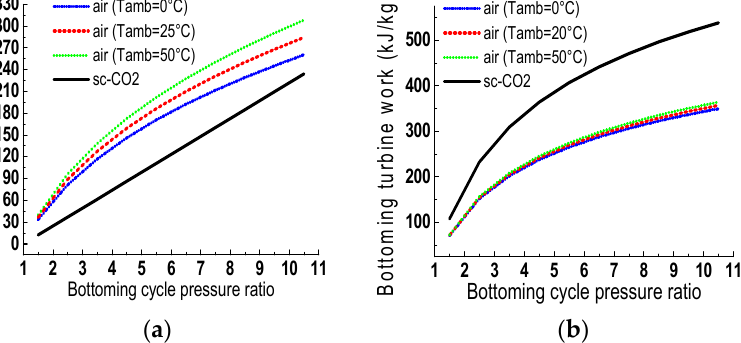
Figure 7. Recovered heat versus bottoming cycle pressure ratio with air at different ambient tem- peratures and with sc-CO 2 . B. Effect of the Ambient Temperature The gas turbines can be used under hard climatic conditions. Far from the ISO stand- ards, the ambient temperature varies considerably during the year; it can often reach over 50 °C involving an important reduction in its performance. Figure 8a–c show the sensitiv- ity degrees of GT-ABC and GT-sc-CO 2 BC net output power and energy and exergy effi- ciency gains, according to the ambient temperature which increases from 0 to 50 °C. Con- trary to the previous case where ASC performances were not sensitive to changes in the parameters set out above, when the ambient temperature varies, ASC performances are directly affected because the inlet air of both topping and bottoming compressors is at atmospheric conditions. Unlike GT-ABC, where the net output power and energy and exergy efficiency gains decrease with the increase in ambient temperature, in GT-sc- CO 2 BC, these performances increase. For an ambient temperature of 50 °C, there is a de- cline in GT-ABC output power gain (Figure 8a), resulting in a decrease in thermal and exergy efficiencies. In Figure 8a, it is noticed that for low temperatures less than 13 °C, the net output power gain difference between the two cycles is weak and their efficiencies are very close. However, it seems that improving an air simple cycle by GT-ABC is better. Since GT-ABC is made up of two compressors that draw in ambient air, at low tempera- ture the air density is greater, which will allow for high power in topping and bottoming cycles. On the other hand, in GT-sc-CO 2 BC, only the topping compressor sucks in ambient air. At 13 °C, GT-ABC and GT-sc-CO 2 BC produce similar power, almost corresponding to the same thermodynamic efficiencies. For a temperature of more than 13 °C there is a sudden increase for GT-sc-CO 2 BC and a decrease for GT-ABC in the net output power and thermodynamic efficiency gains. When the compressor inlet temperature is high, it